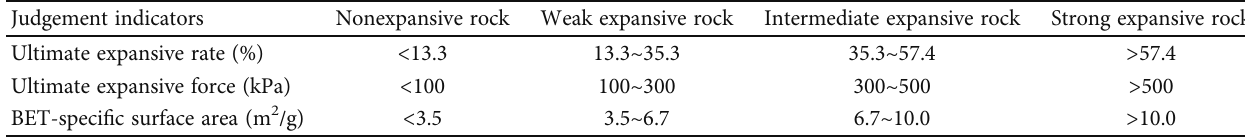
Table 8: Classi fi cation of the expansion potential of gypsum